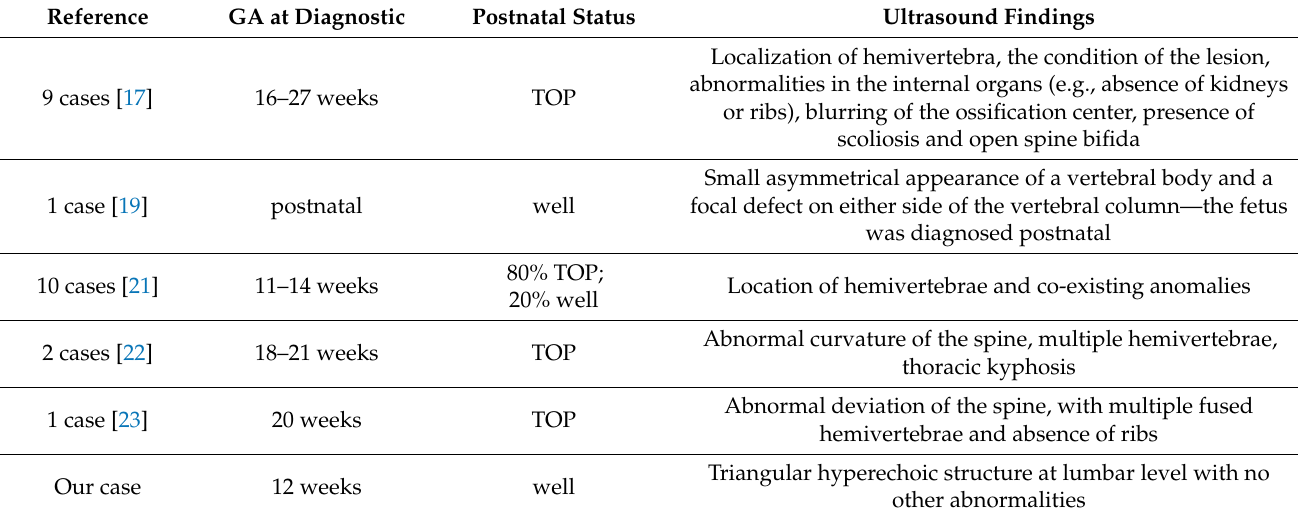
Table 1. Summary of the characteristics of other cases of supernumerary vertebra, compared to our